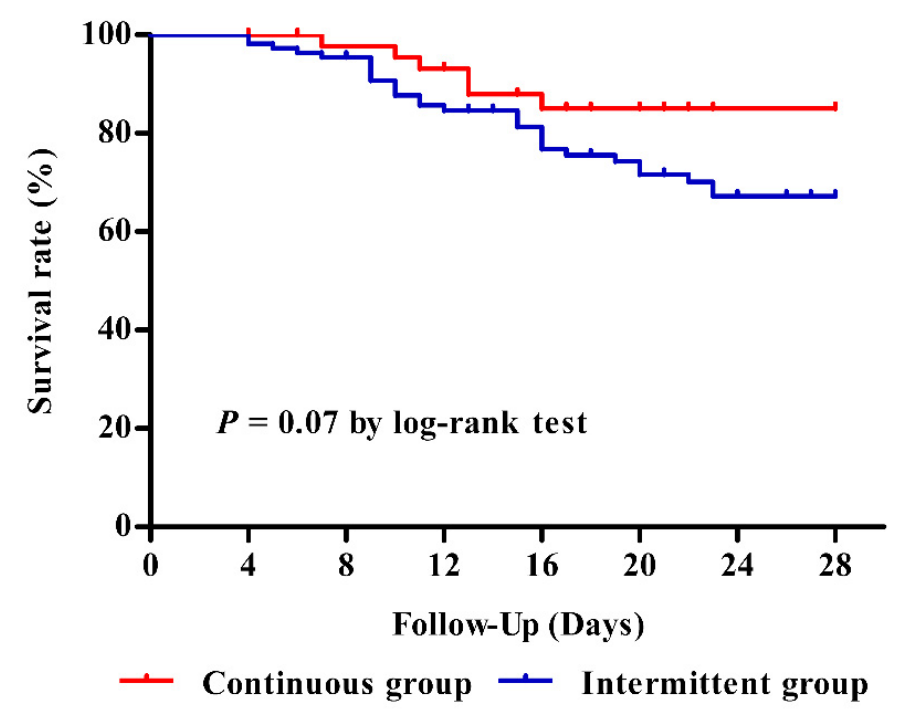
Figure 2. Kaplan–Meier curves of mortality at 28 days in patients with sepsis according to the type of administration of piperacillin-tazobactam.